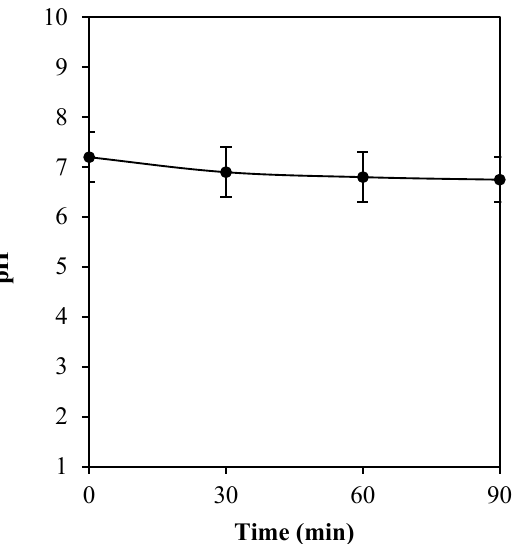
Figure 7. The pH alteration of cathodically electrical polarization of titanium substrate for 30, 60, and 90 min. The values are expressed as mean ± SD ( n = 3).